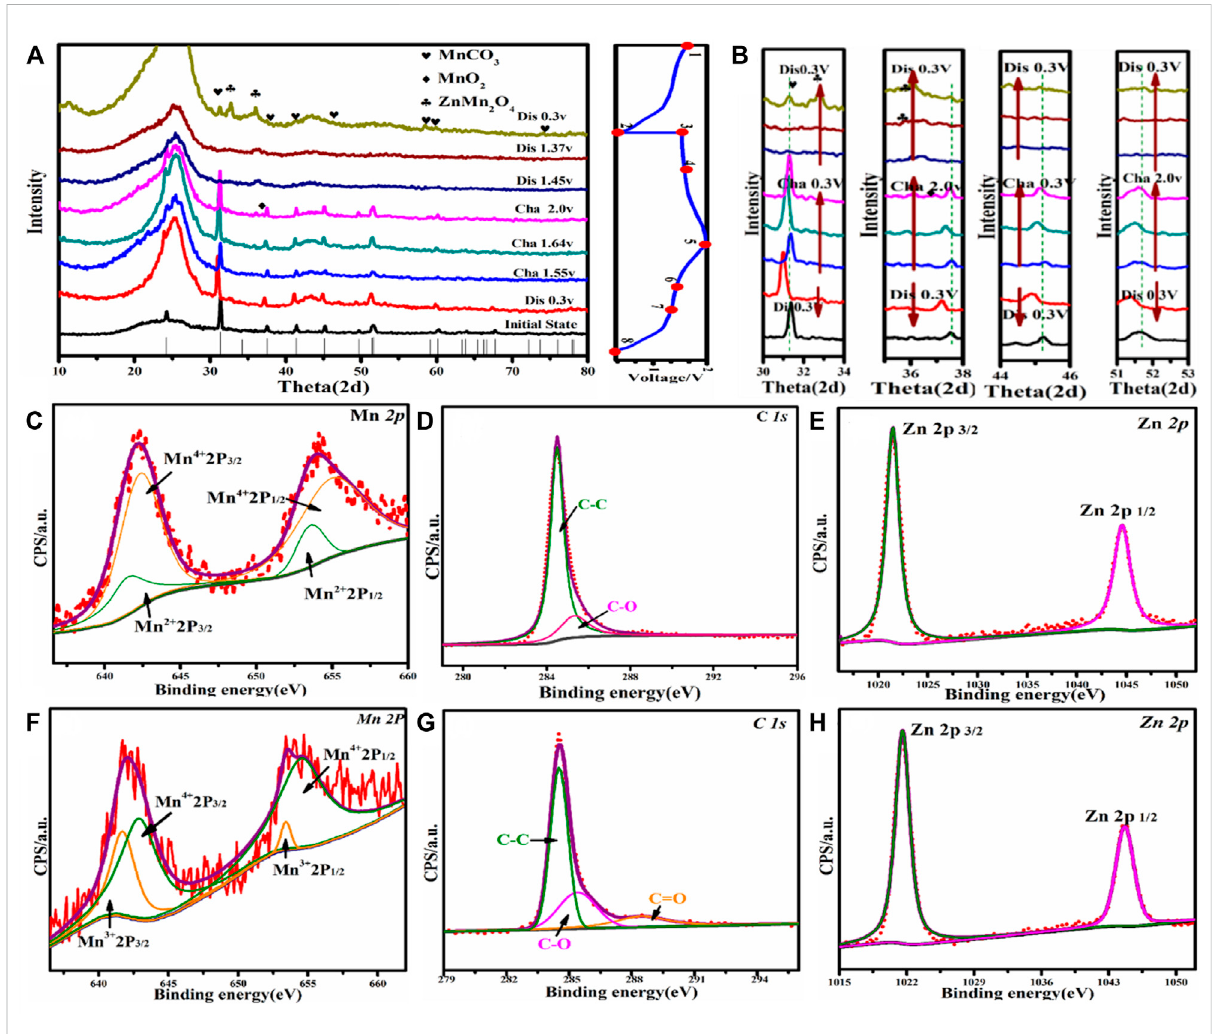
FIGURE 4 (A) EX-XRD patterns of MnCO 3 @CC at 0.1 A g − 1 . (B) Angular shifts of different diffraction peaks. (C – E) The XPS patterns of MnCO 3 @CC for Mn, C,and Znelements underchargeto2.0 Vat0.1 A g − 1 . (F – H) TheXPSpatterns ofMnCO 3 @CC forMn,C,andZnelementsunderdischarge to0.3 Vat 0.1 A g − 1